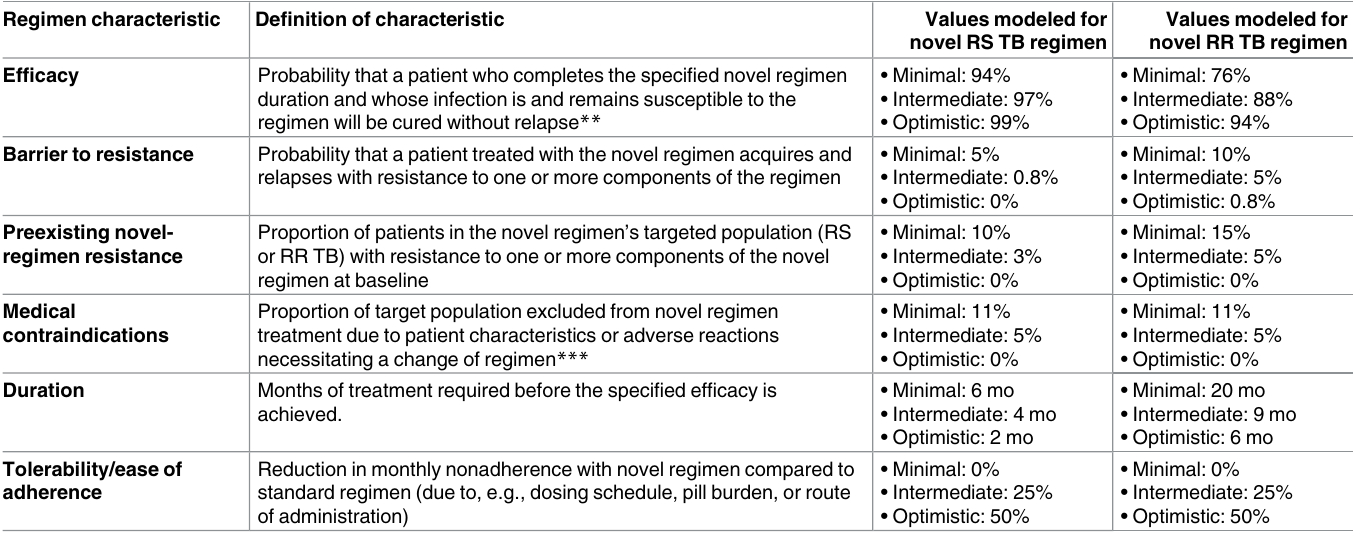
Table 1. Modeled novel regimen characteristics and target values *